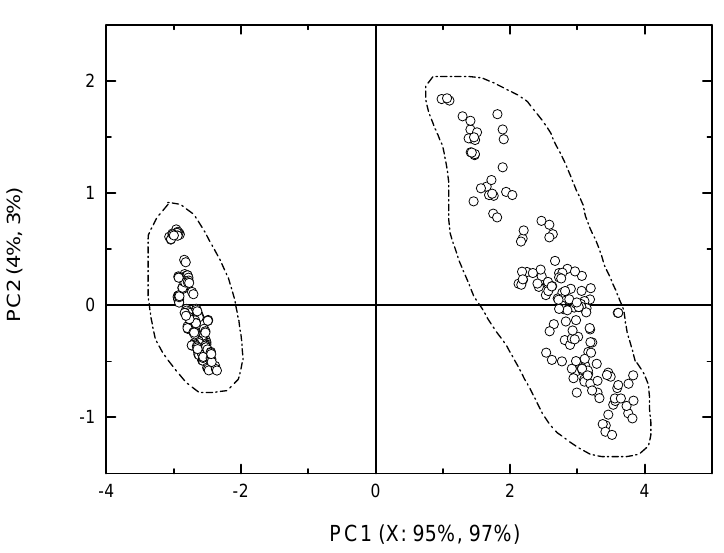
Figure 5 . PLS-1 score plot of all samples in test mixtures of key odorants containing p-cresolate at pH 6 (to right) and at pH 8 (to left). Full cross validation, PLS-DA was used and eight electrodes were